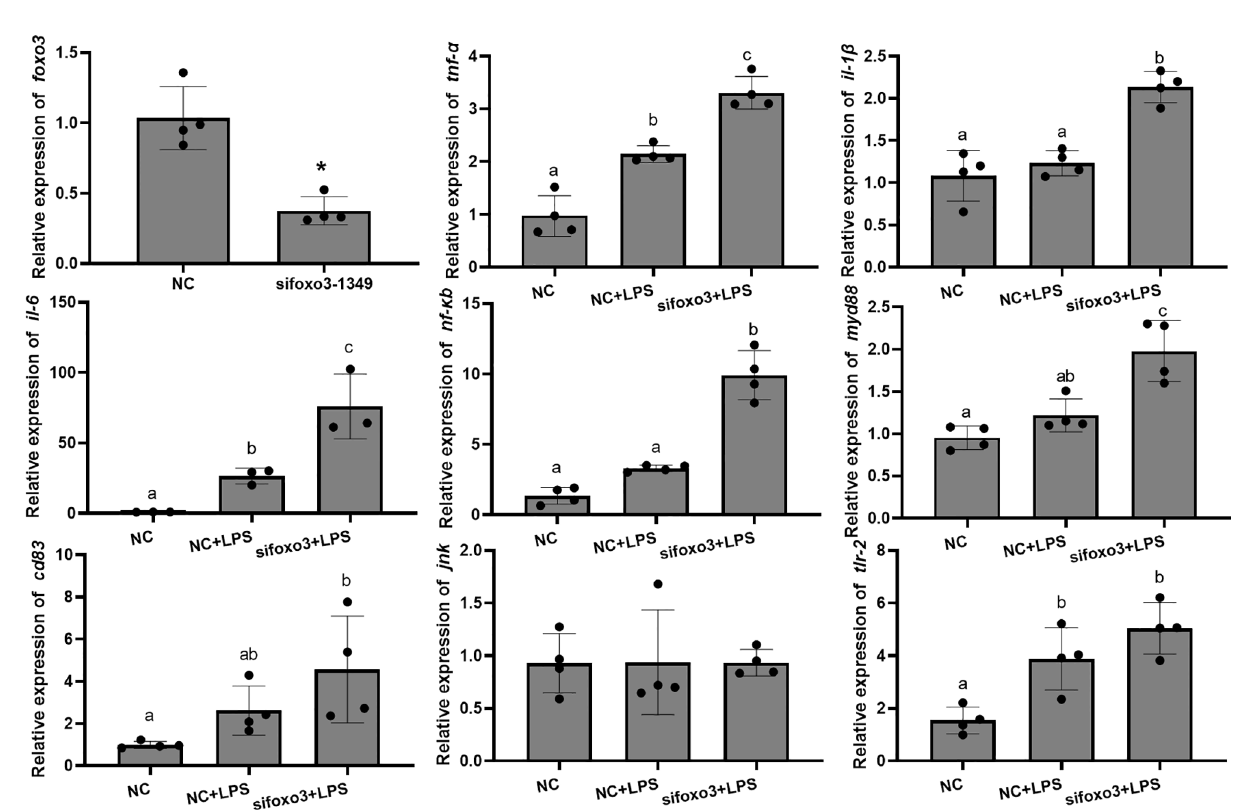
FIGURE 6 | Relative mRNA expression of foxo3 , tnf- a , il-1 b , il-6 , nf- k b , myd88 , cd83 , jnk , tlr-2 in turbot liver. The results are expressed as the mean ± standard deviation (n = 4). ‘ * ’ means signi fi cantly different between two group ( P < 0.05). The different letters are signi fi cantly different ( P <